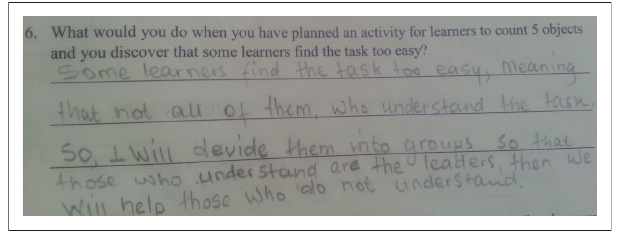
FIGURE 9: Response of Teacher 9.